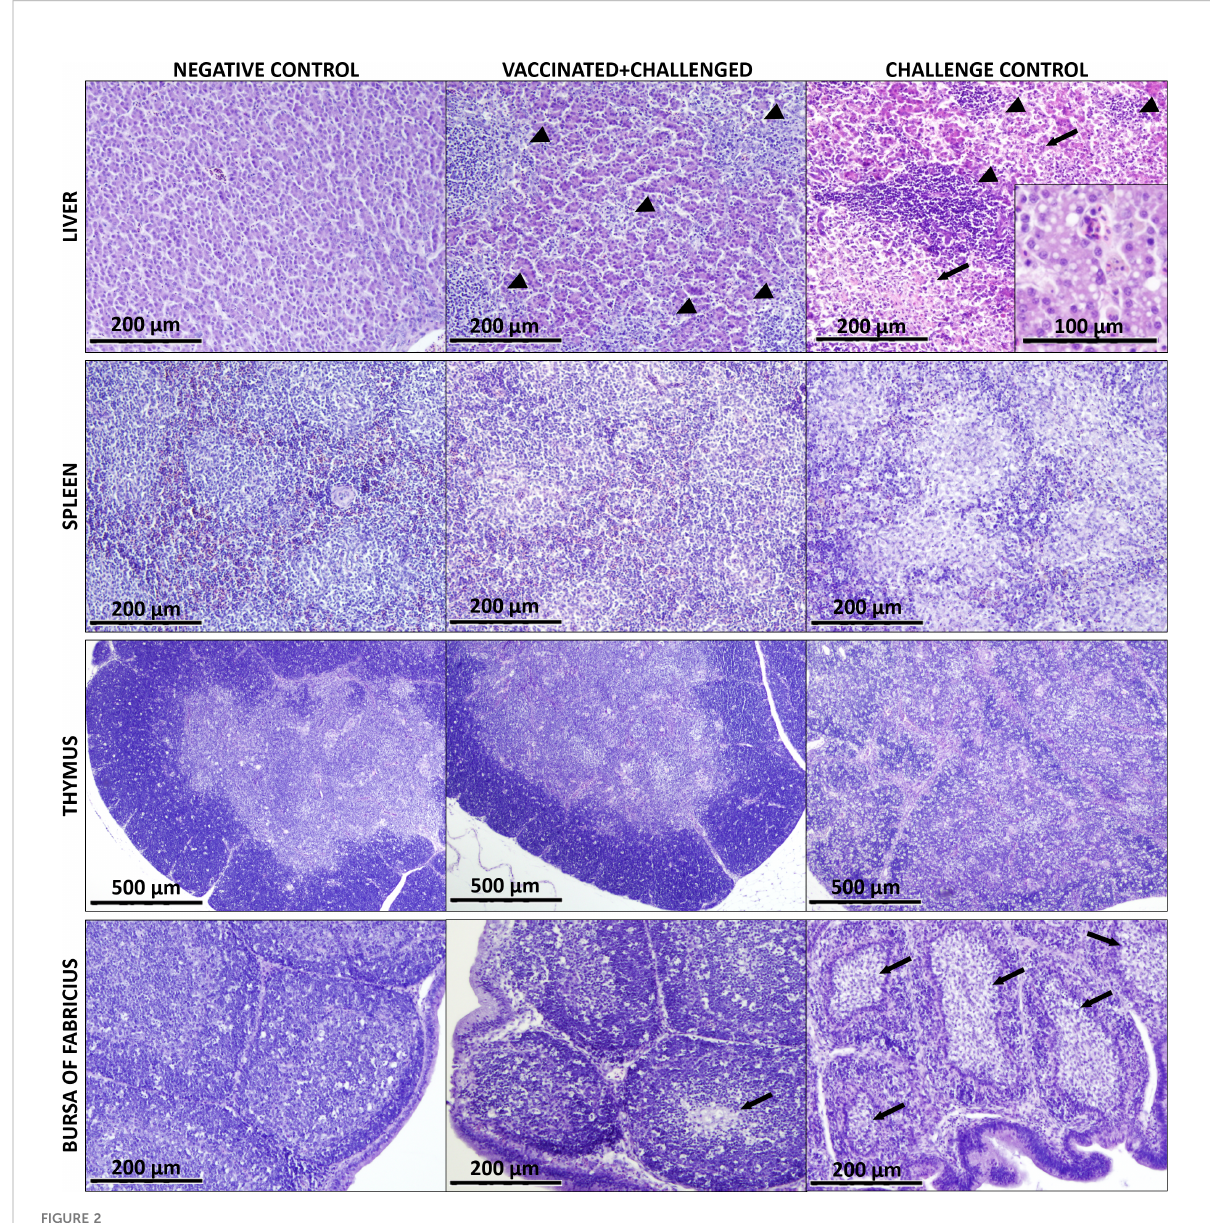
FIGURE 2 Main histological lesions observed in the analyzed organs of birds from negative control, vaccinated+challenged, and challenge control group. The liver of vaccinated+challenged group presents lymphocytic in fi ltration (marked by arrow heads) and small areas of degeneration (arrows), which can be seen more severe in the challenge control. Vacuolization of the hepatocytes is shown in a magni fi ed fi eld for the challenge control. Lymphocytic depletion is visible in the spleen and thymus of the challenge control group. The bursa of Fabricius of the vaccinated+challenged group shows mild